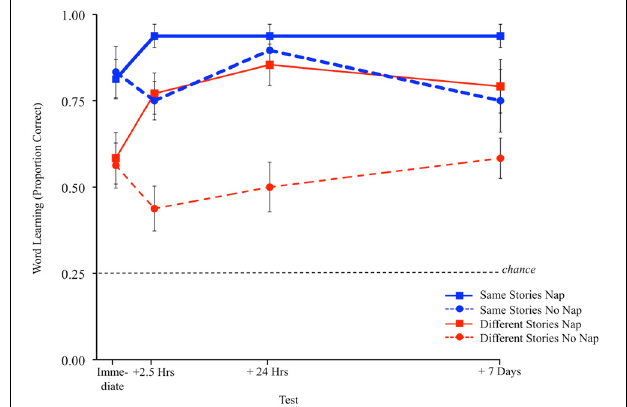
FIGURE 2 | Children’s word learning on each test for each of the four conditions. Chance is 0.25. Error bars indicate one standard error of the